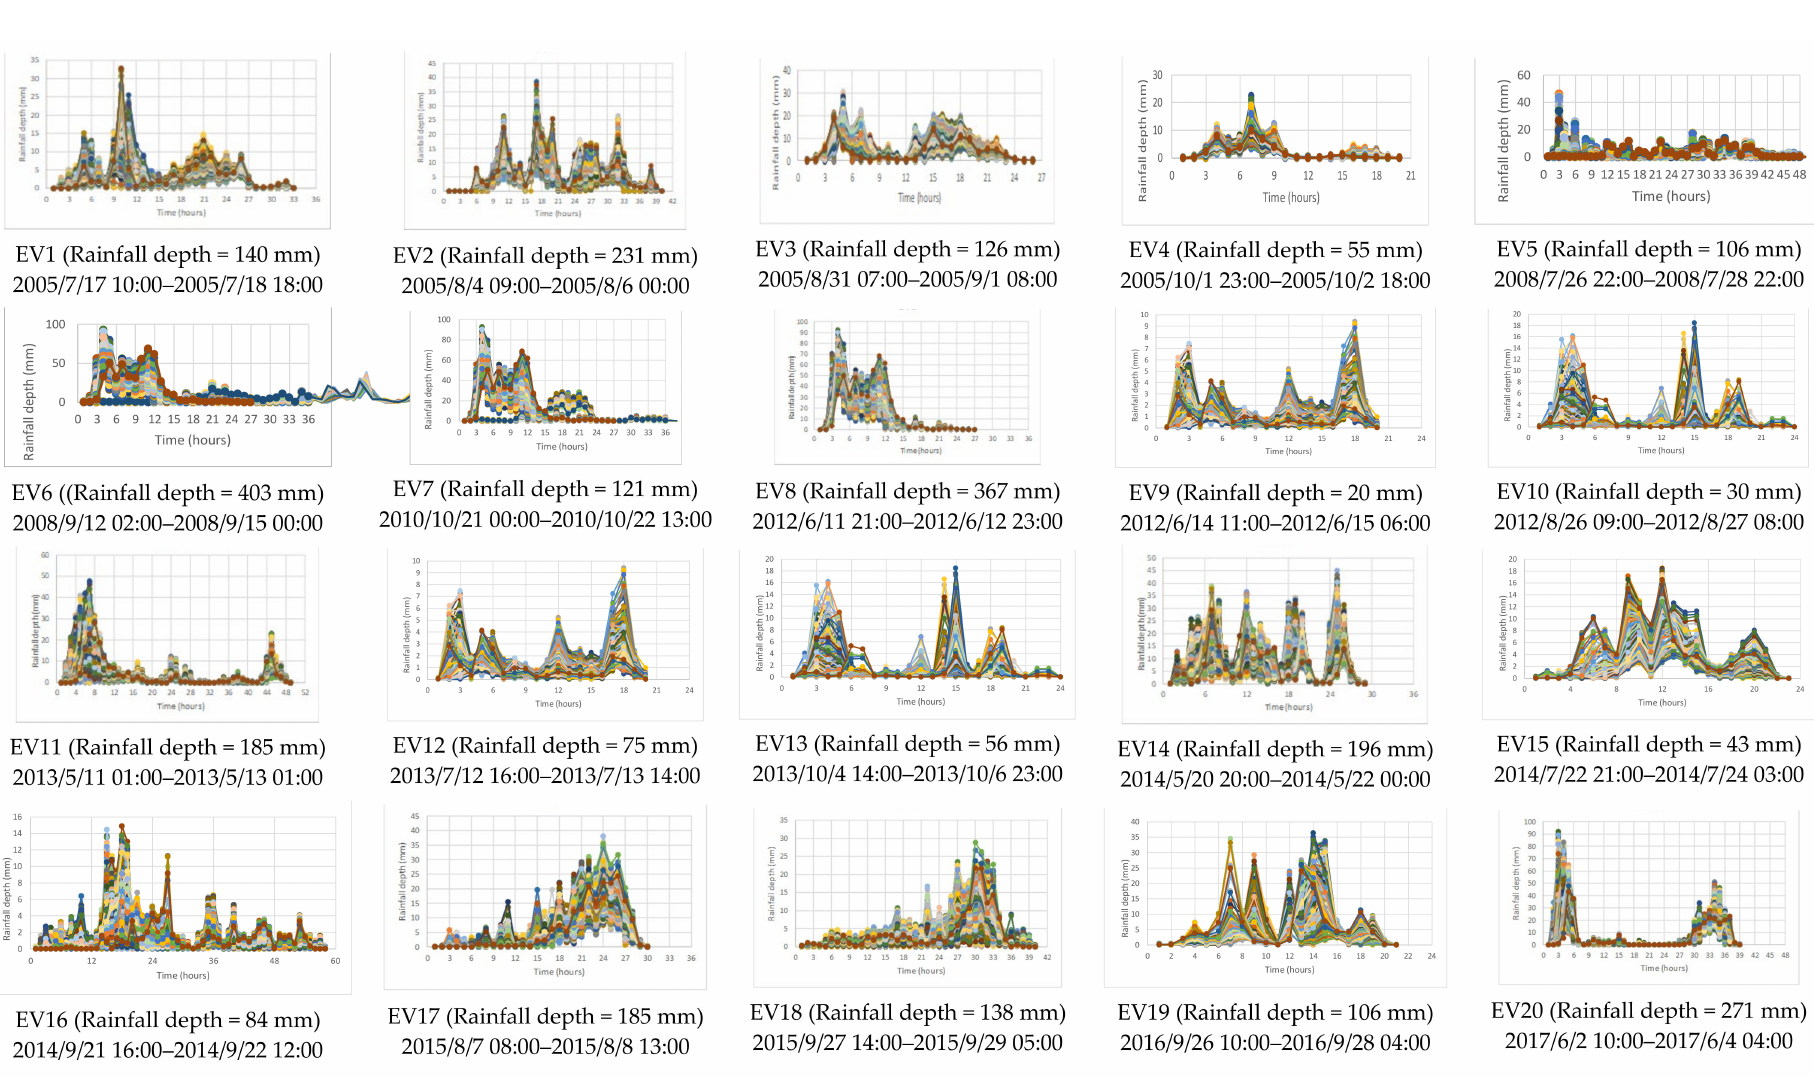
Figure 5. Hyetographs of 20 observed rainstorm events used in the model development and application